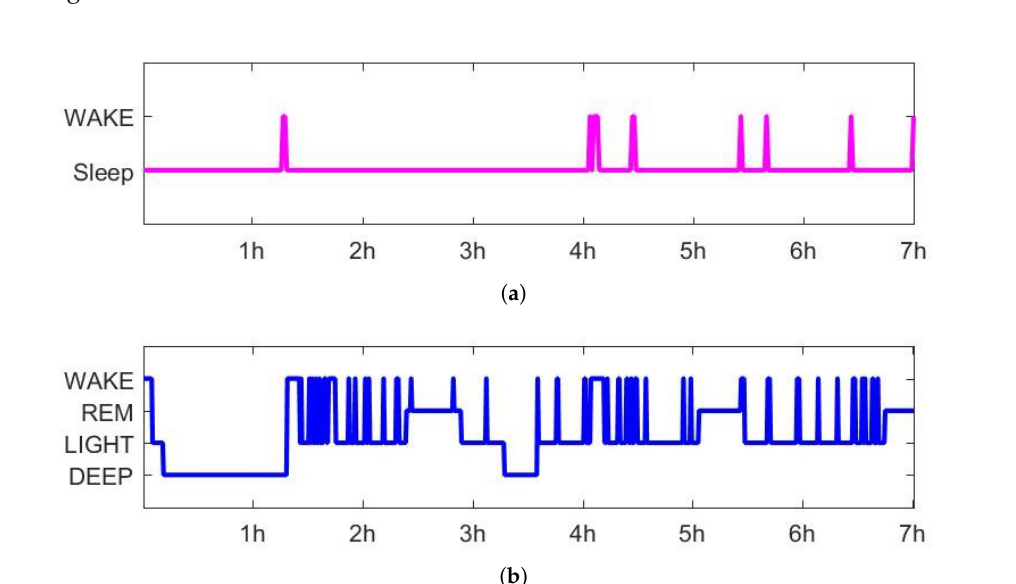
Figure 5. The estimated hypnogram using the ( a ) Sadeh algorithm from the actigraph and ( b ) HMM algorithm from